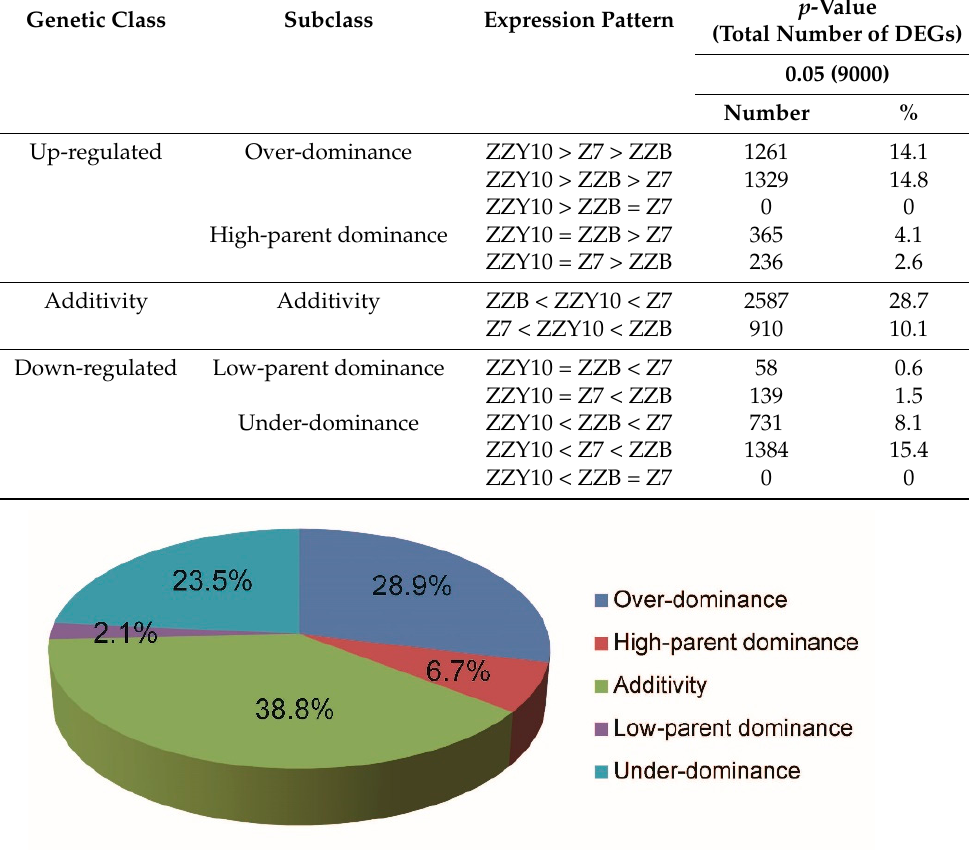
Figure 2. Breakdown of the DG HP according to the expression pattern. Table 3. DEGs between the hybrid ZZY10 and its parents.